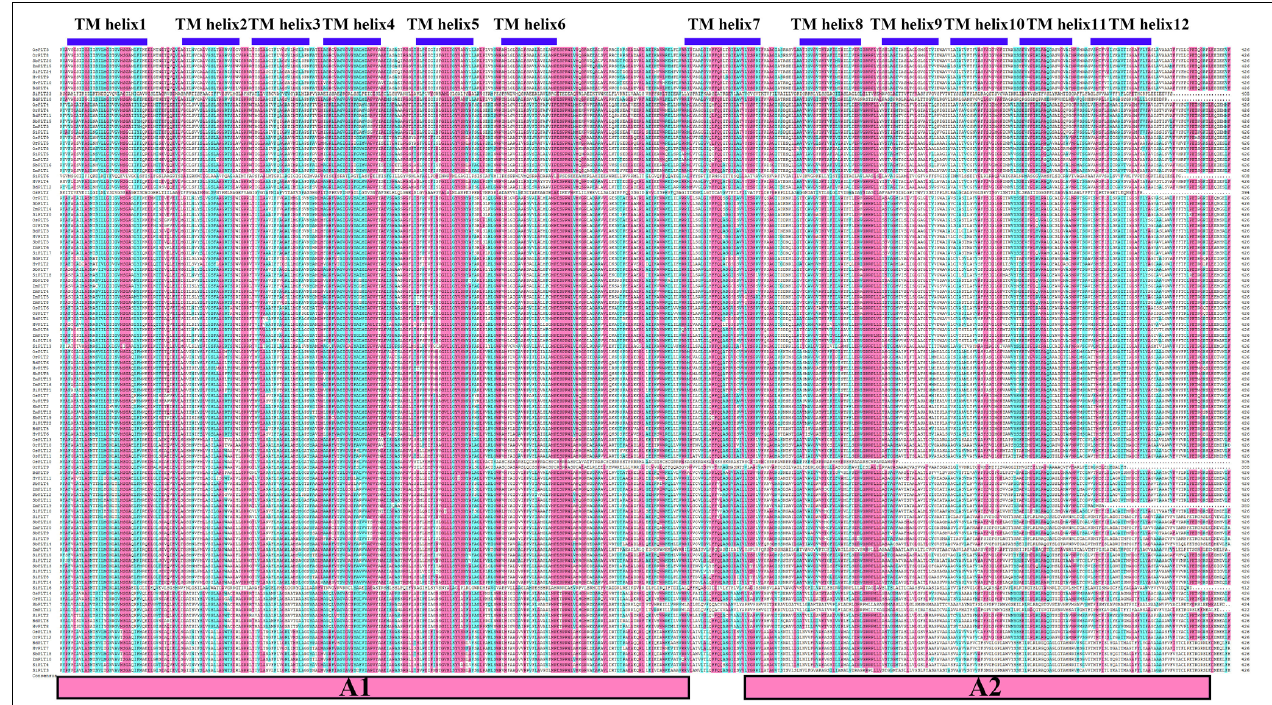
FIGURE 4 | Sequence alignment result of polyol transporter protein sequences. The residues in red background represent the highly conserved residues. Twelve transmembrane helices were marked by blue boxes and the two functional duplicated regions are shown in red boxes at the bottom, namely, A1 and A2.